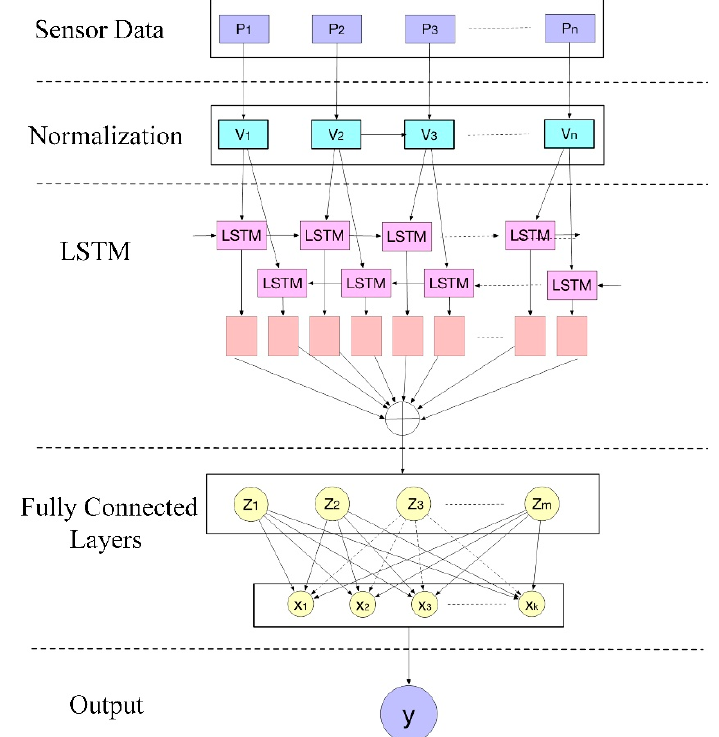
Figure 4. Defecation perception solution based on